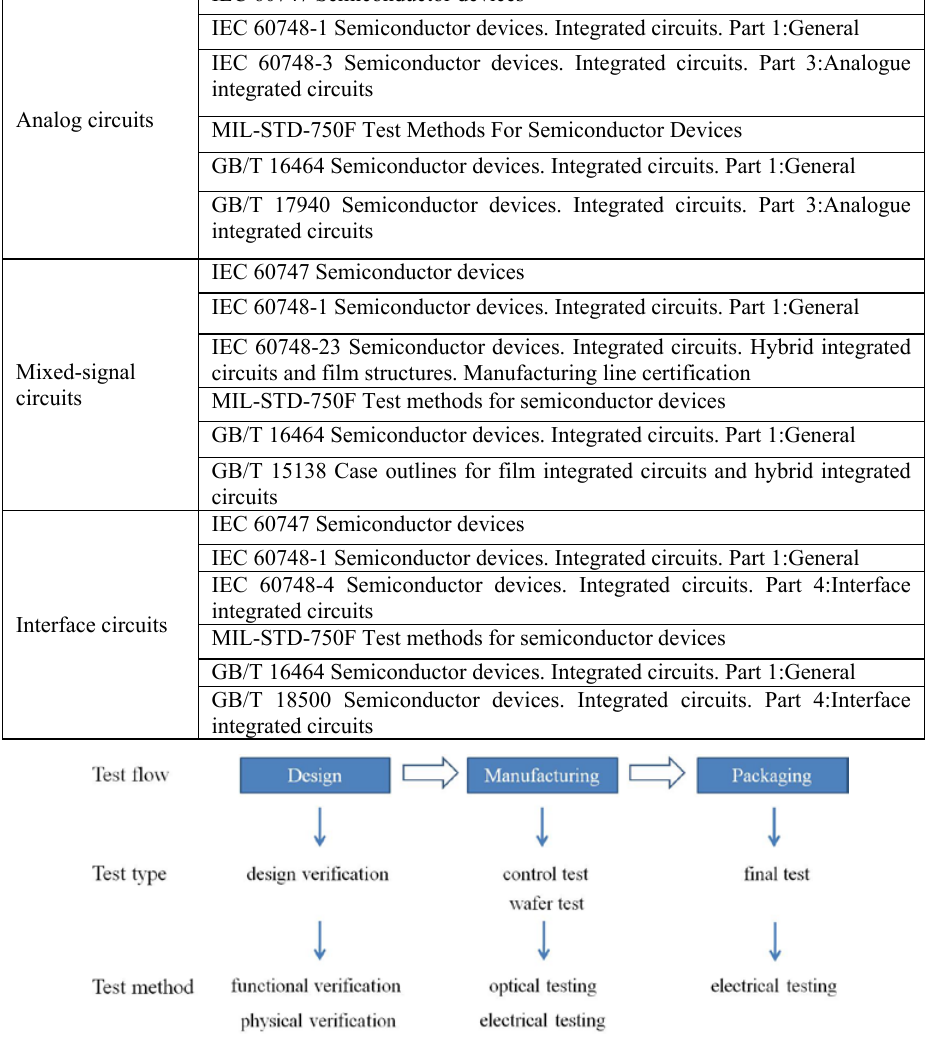
Fig. 1. Test parts in IC